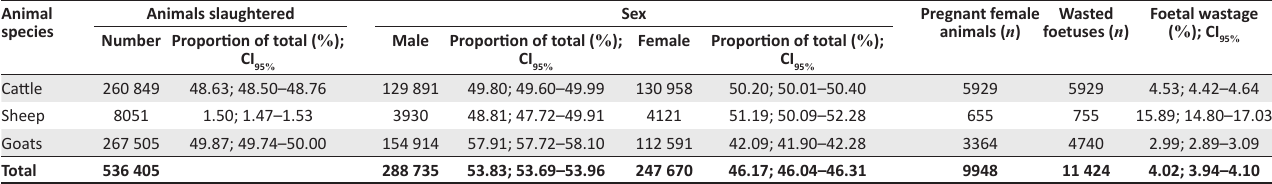
TABLE 1: Summary of the number of ruminants slaughtered at Minna Municipal Abattoir, Nigeria, 2001–2012. Animal Animals species